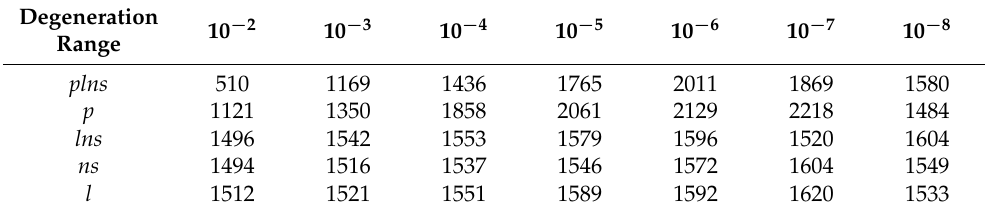
Table 5. Effect of degeneration range on low-probability password hits (Rule 4).